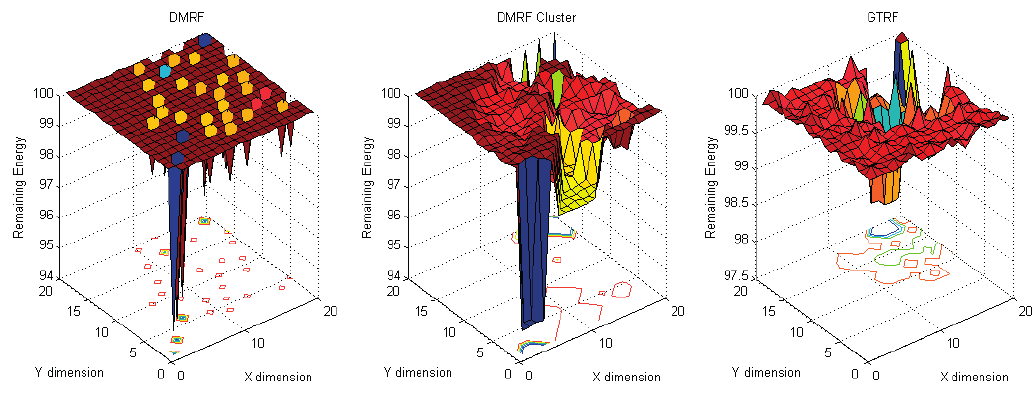
Figure 5. Energy cost with fixed source and fixed sink without selfish